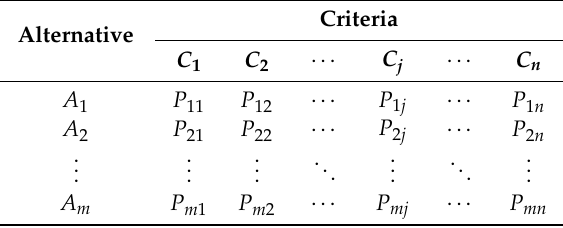
Table 1. Original decision matrix of scores for alternatives versus criteria. Criteria Alternative C 1 C 2